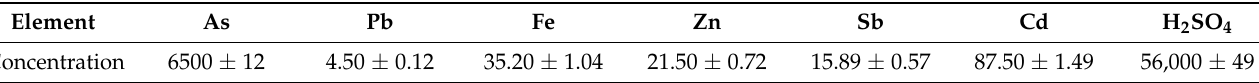
Table 2. Chemical composition of the arsenic wastewater